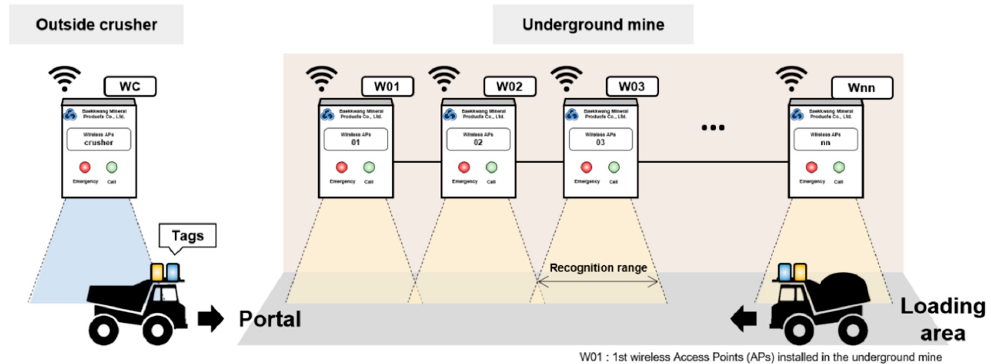
Figure 3. Diagram showing the sequence of wireless APs in the underground mine.